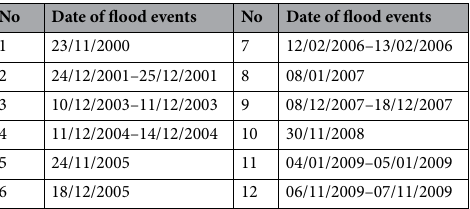
Table 2. Dates in which the water level data exceeded the danger water level (16 m) of Kelantan River—the data are obtained from the Guillemard Bridge station from 01/01/2000 to